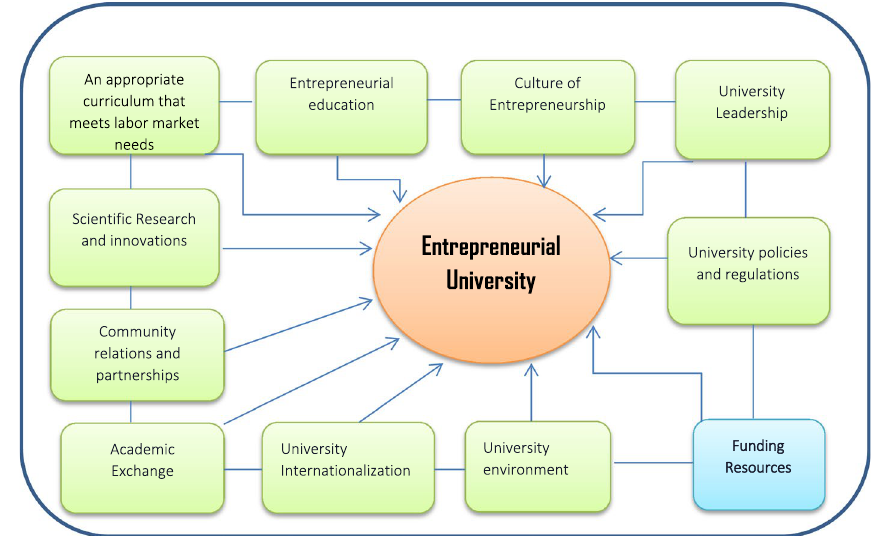
Fig. 6 PPU entrepreneurial university